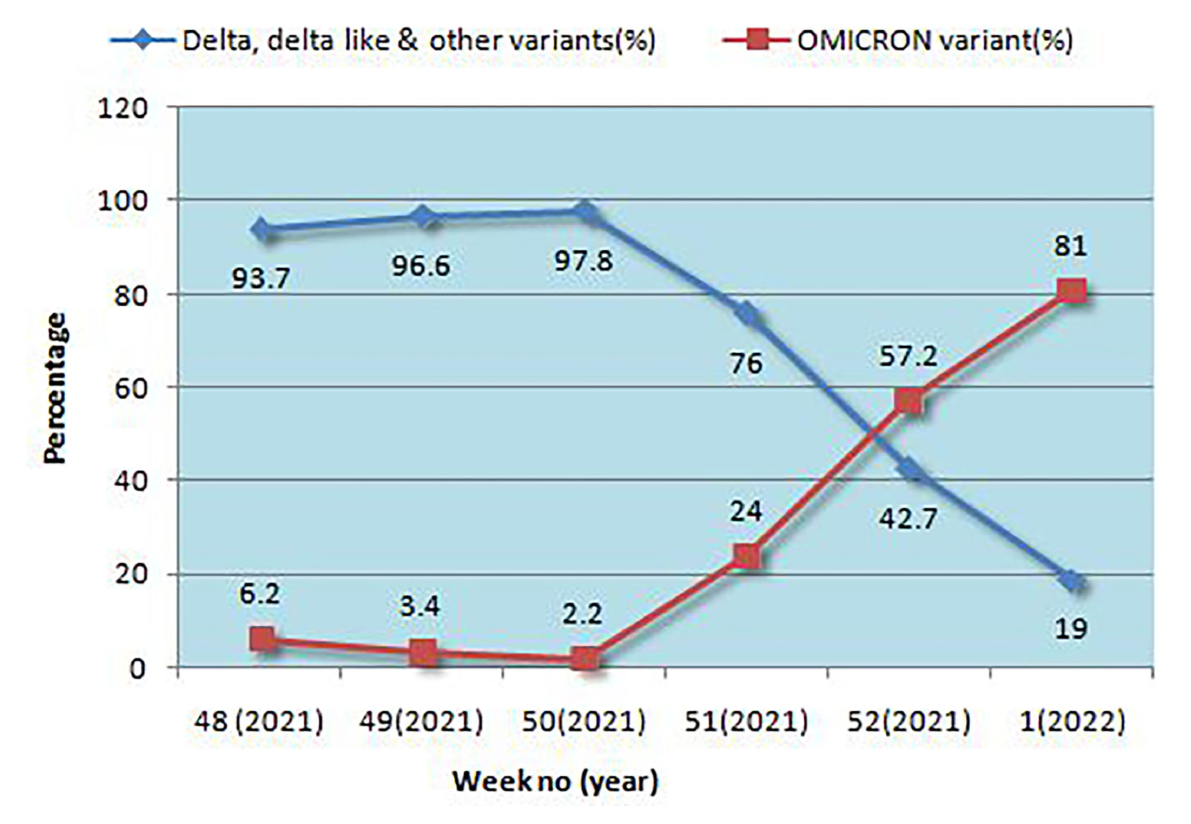
FIGURE1 Week wise PCR positivity in Omicron and Delta